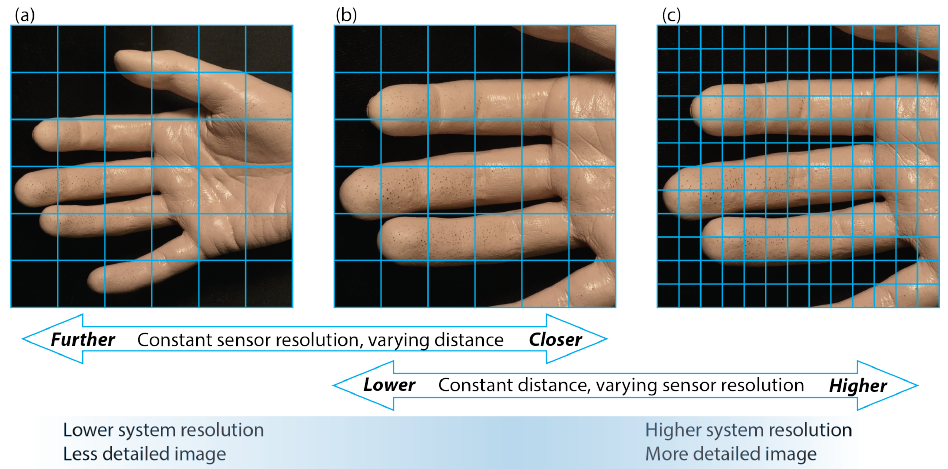
Figure 6. The effect of system resolution on the image detail level. Each square on the grid represents an individual pixel. ( a , b ) Varying distance or field of view, sensor resolution is left unchanged. ( b , c ) Varying sensor resolution for a fixed optical